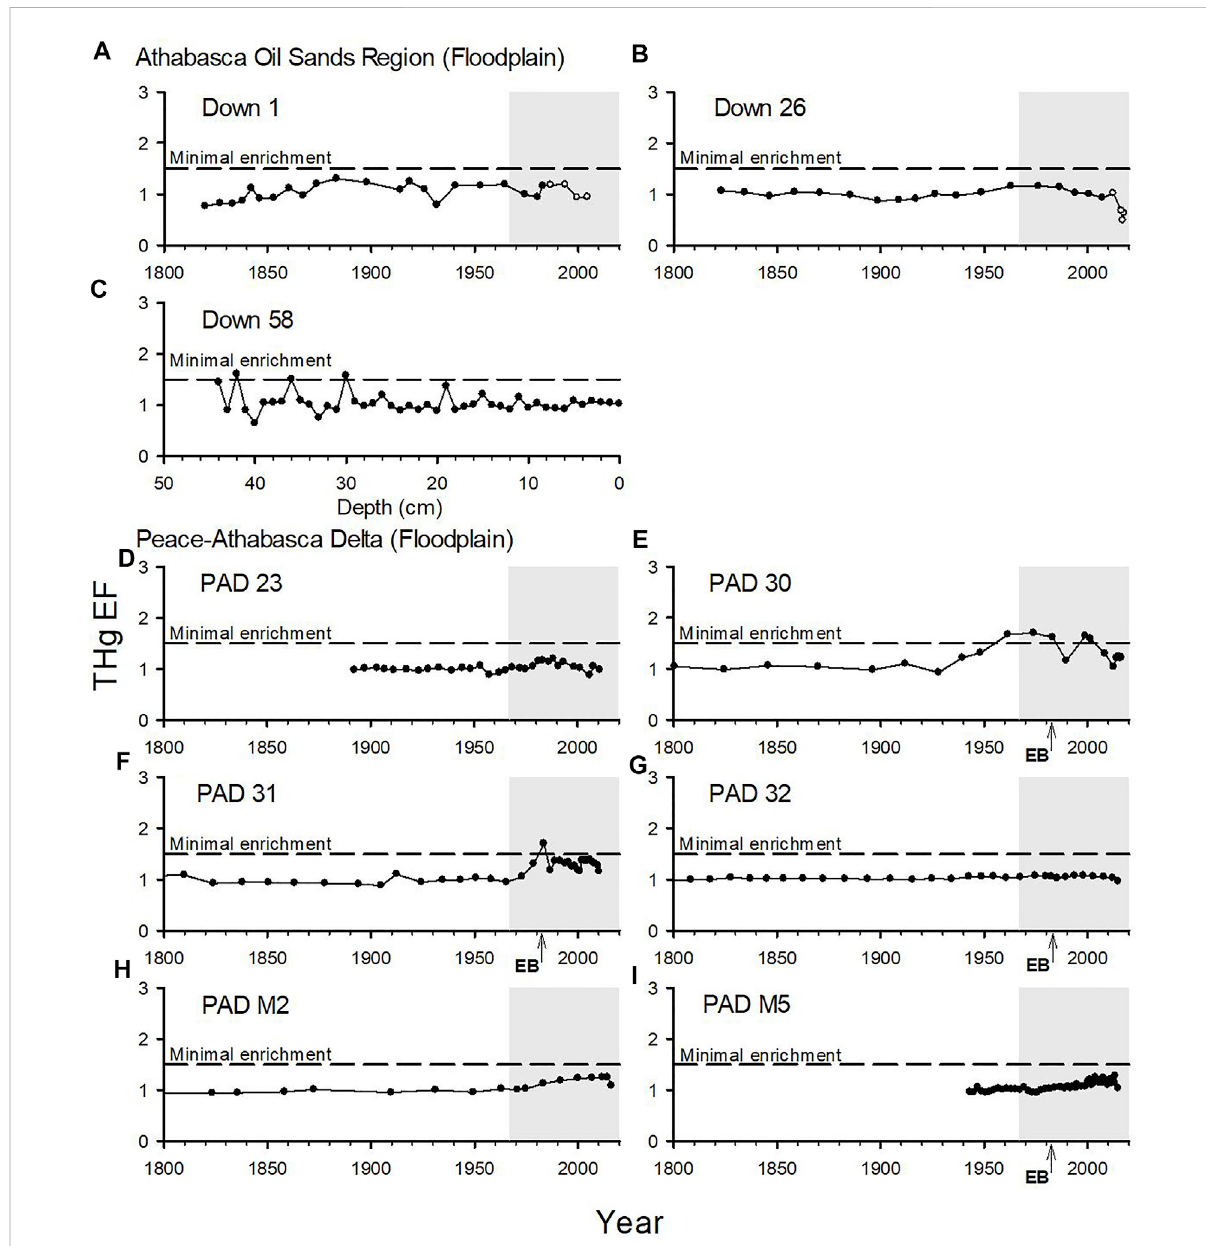
FIGURE 2 TimeseriesofTHgenrichmentfactors(EFs)relativetotheaveragepre-1900concentrationat fl oodplainlakesintheAOSR (A – C) andPAD (D – I) . The horizontal black dashed line at EF of 1.5 marks the “ minimal enrichment ” threshold (Birch 2017) and the grey shaded region denotes the interval of oil sands mining and processing activities on the Lower Athabasca River beginning in 1967. The white circles for Down 1 and Down 26 indicate periods of weak river in fl uence identi fi ed by Klemt et al. (2020). The EB denotes the 1982 Embarras Breakthrough, which resulted in increased river in fl uence at PAD 30 and PAD 31 and decreased river in fl uence at PAD 32 and